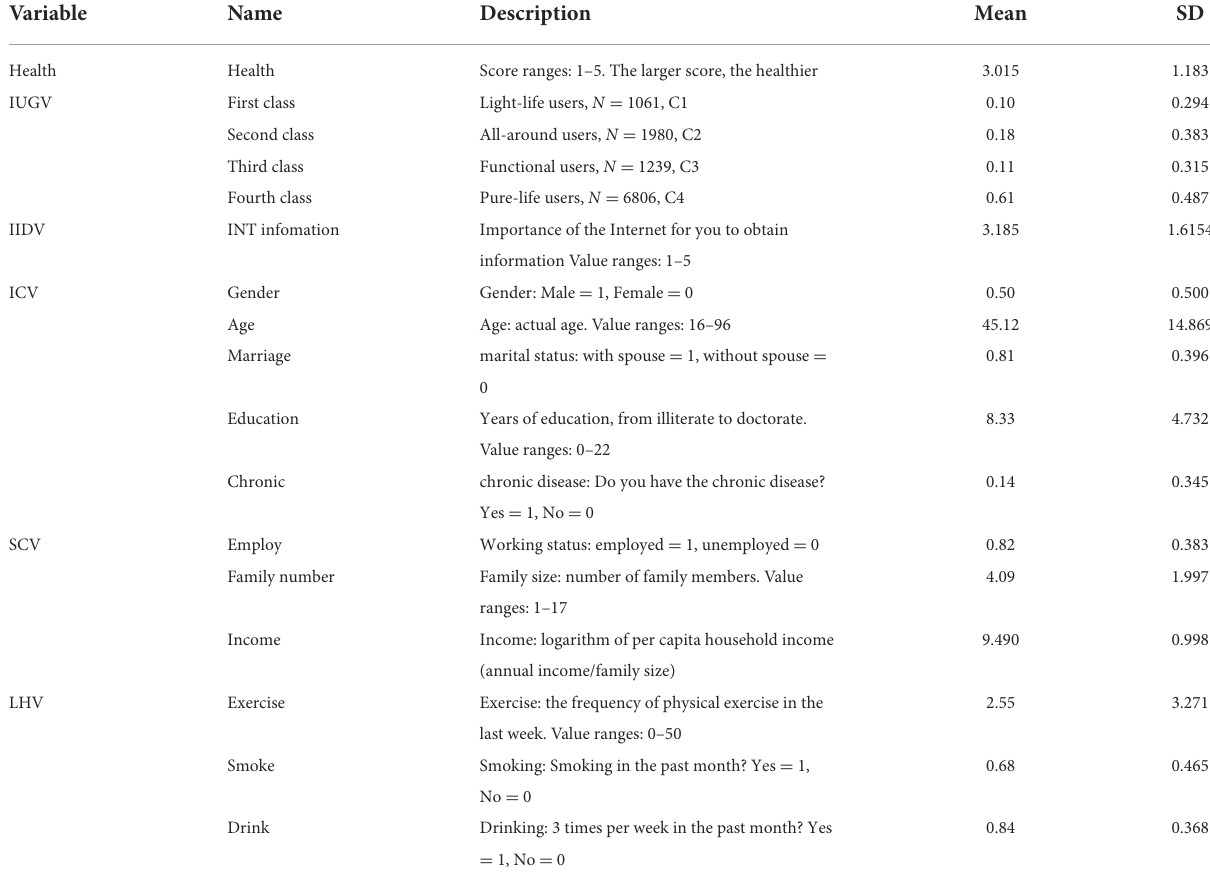
TABLE 1 Variable description and descriptive